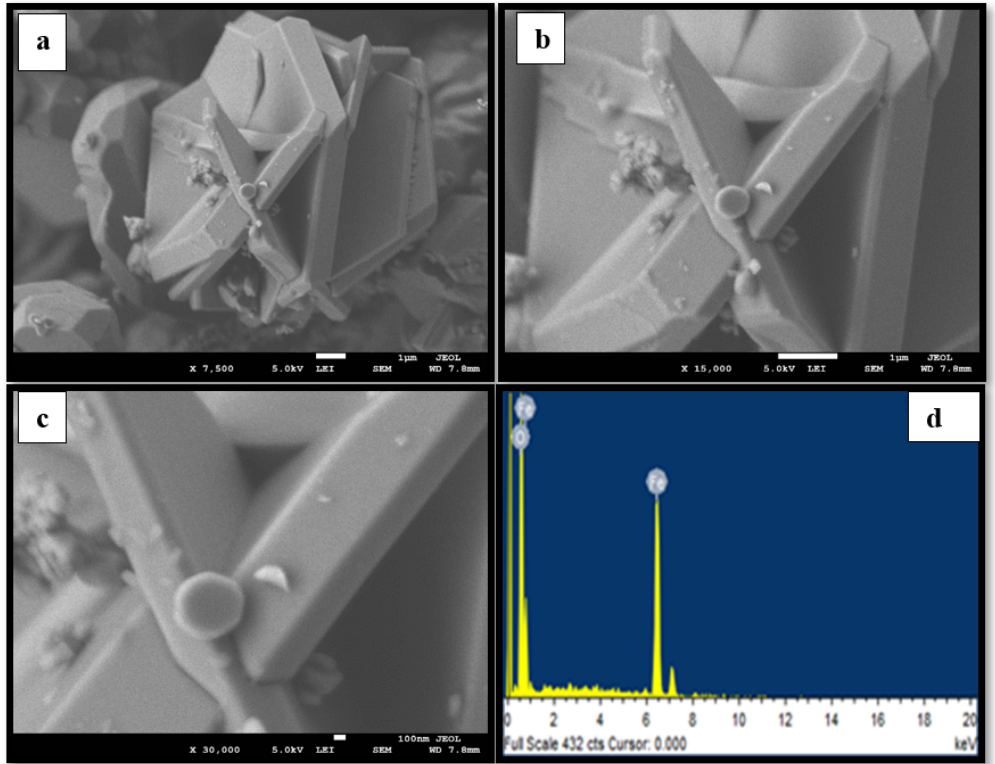
Figure 1. Representative FESEM images ( a – c ) at different magnifications of the synthesized Fe 3 O 4 NPs and ( d ) EDS.